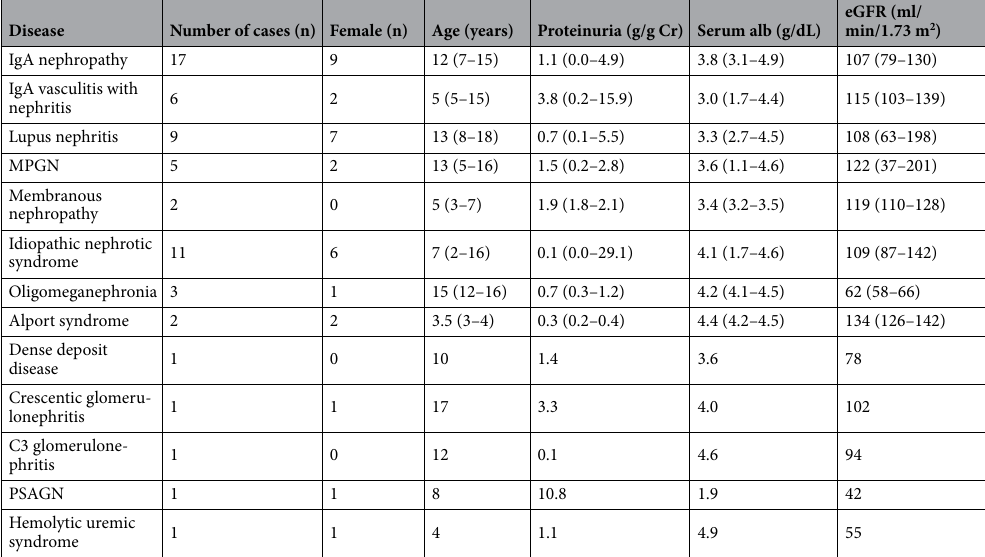
Table 2. Characteristics of enrolled patients. Data were obtained at the time of renal biopsy and are presented as median (range). alb albumin, eGFR estimated glomerular filtration rate, MPGN membranoproliferative glomerulonephritis, PSAGN poststreptococcal acute